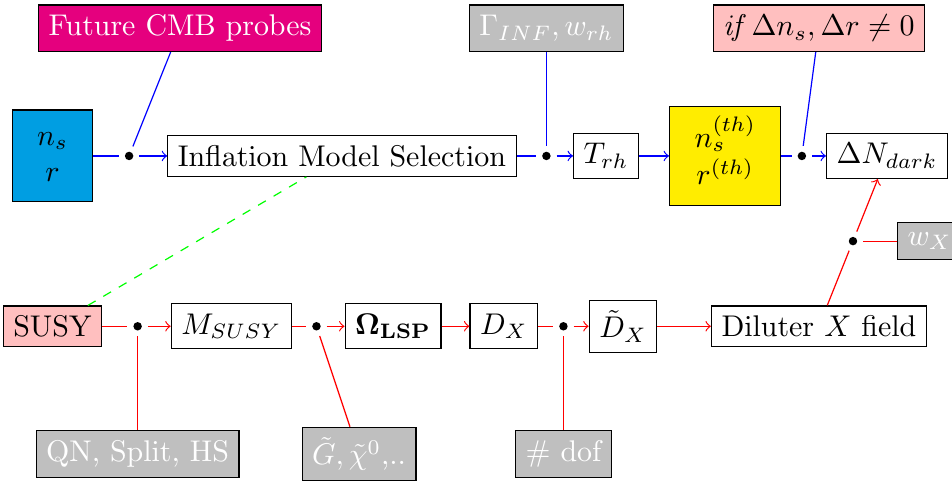
Figure 9 . This graph demonstrates the analysis followed in this work to cosmologically probe BSM